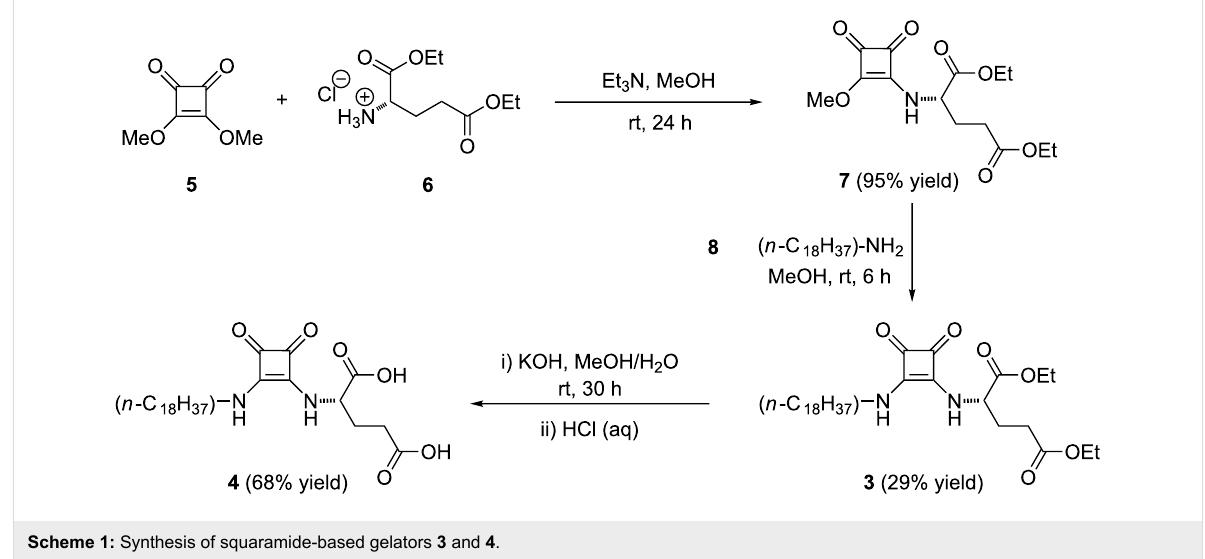
Scheme 1: Synthesis of squaramide-based gelators 3 and 4 .